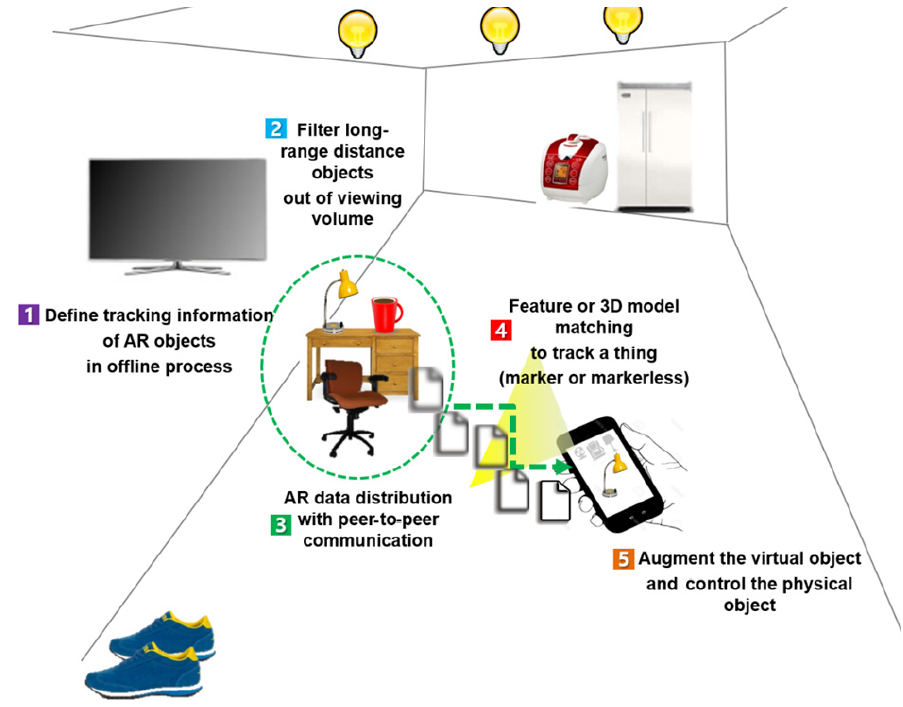
Figure 6. Future distributed data management scheme for “everywhere” augmented reality (AR) service for physical objects.